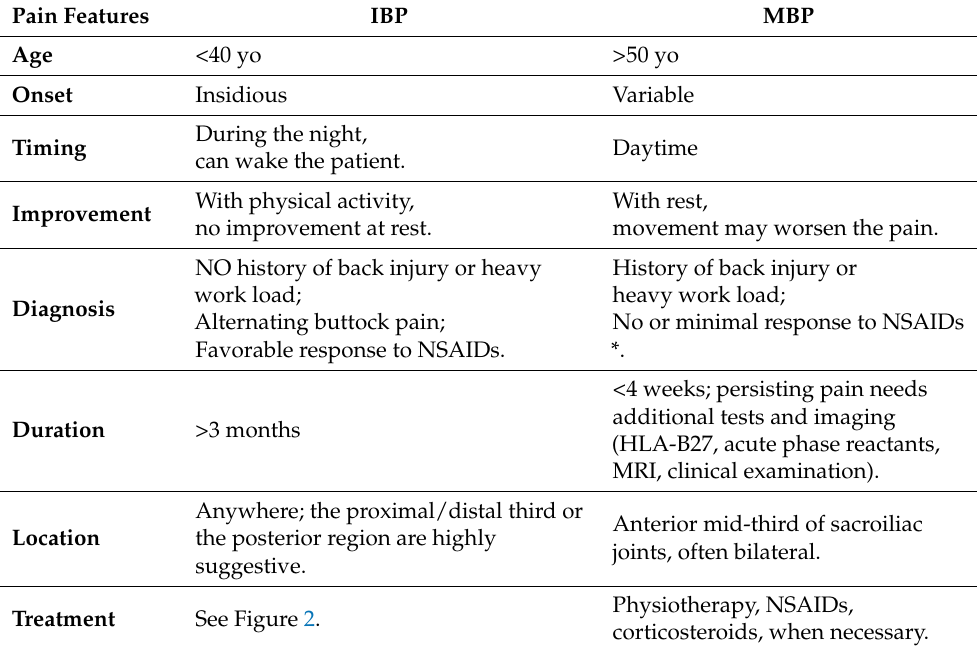
Table 2. Differences between IBP and